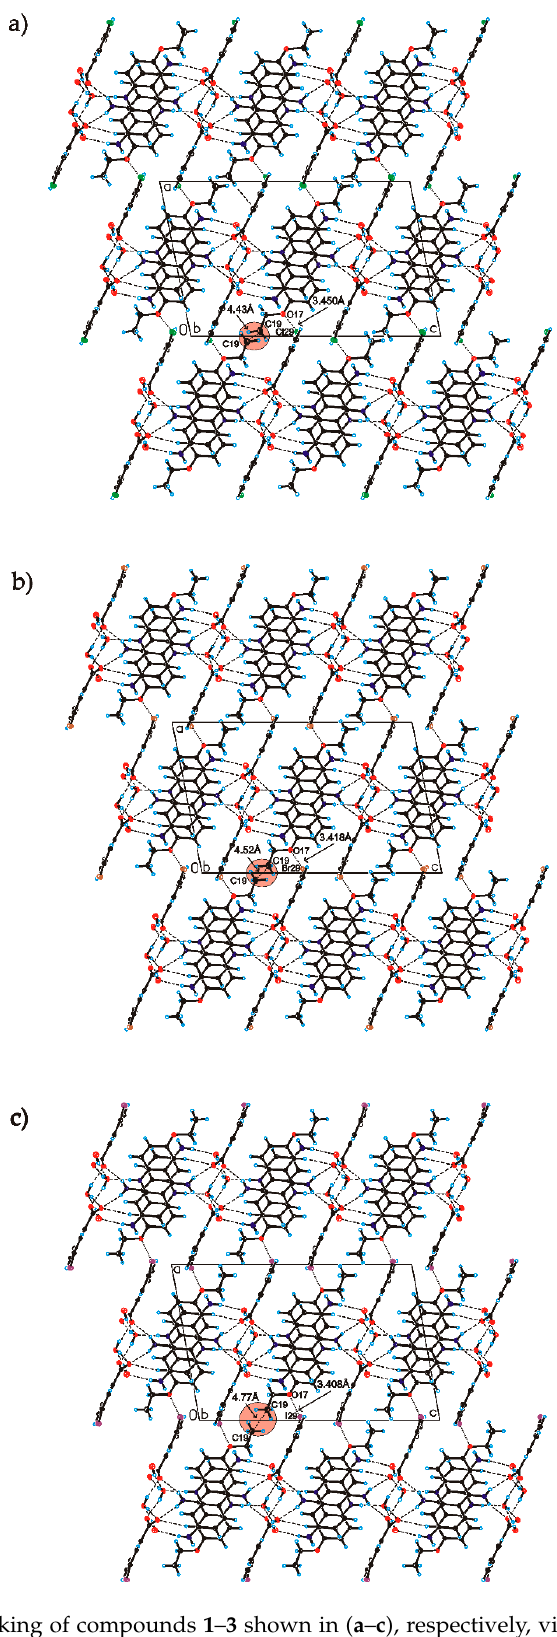
Figure 4. Crystal packing of compounds 1 – 3 shown in a–c, respectively, viewed along the b -axis (hydrogen bonds and halogen bonds are represented by dashed lines, whereas C19···C19 (highlighted in pink) and X29···O17 distances are represented by dotted lines).